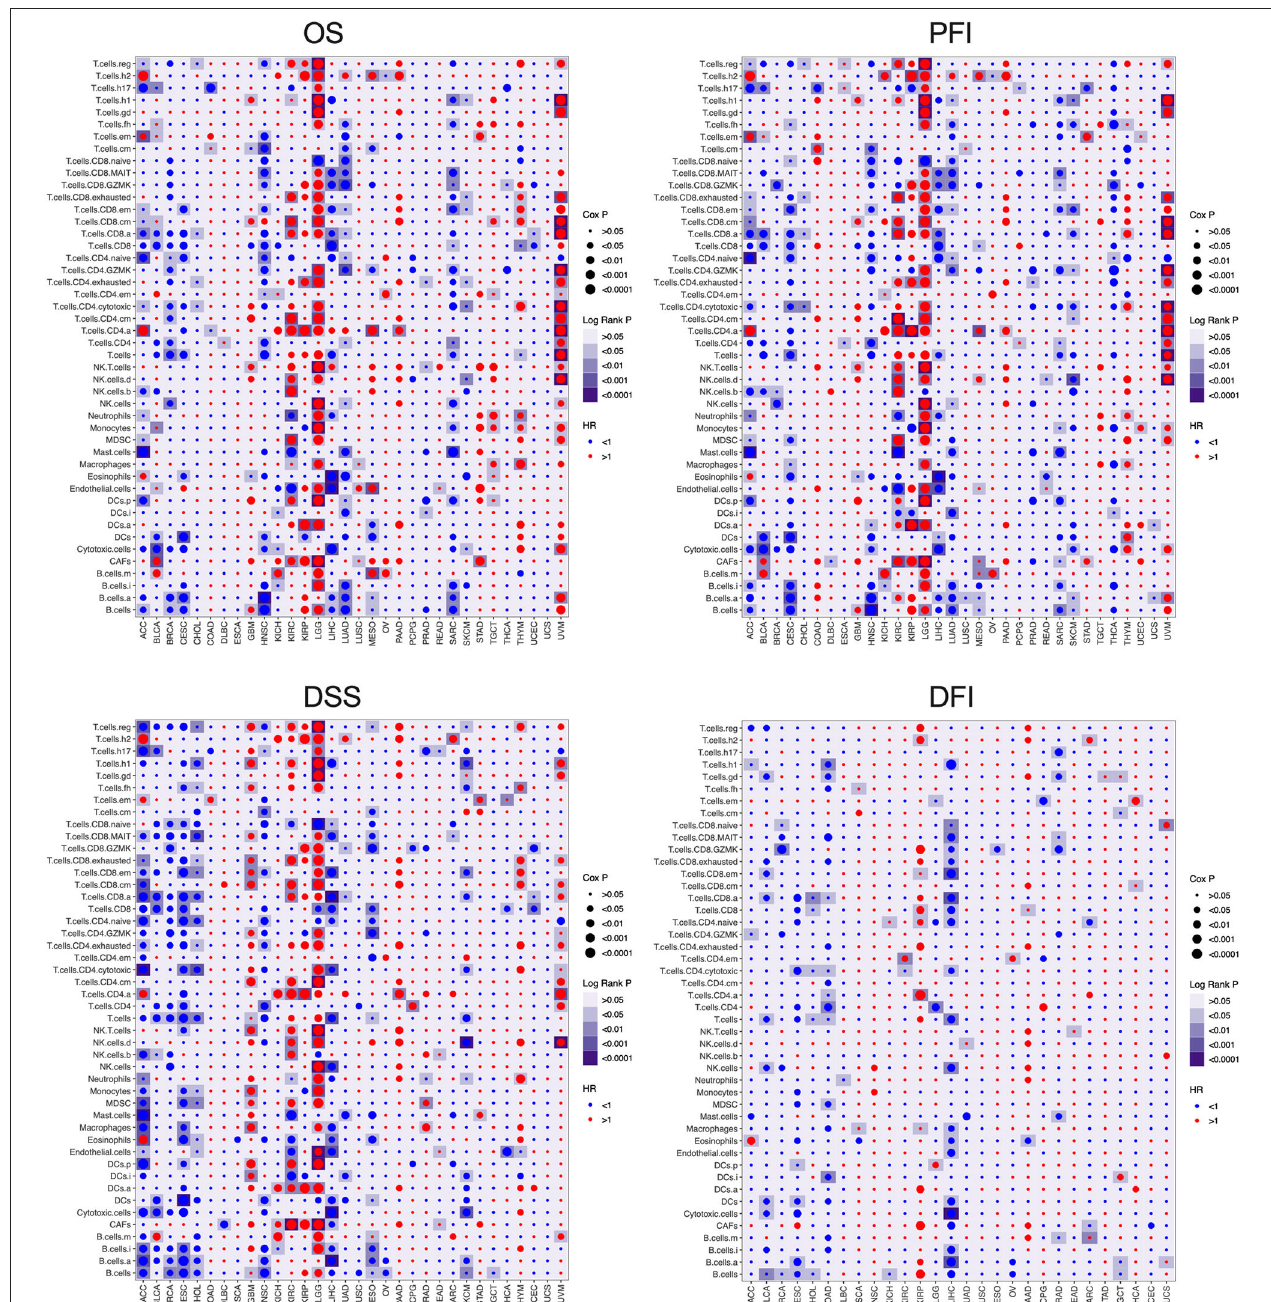
FIGURE 3 | The prognosis value of the infiltrating immune cells in each cancer type. The association between the infiltrating immune cells and the survival of tumor patients was investigated using Cox regression and log-rank methods. The hazard ratio (HR) is < 1.0, indicating a good effect on prognosis, and the HR value is greater than 1.0, indicating an adverse effect on prognosis. Cox P is represented by the size of points, and log-rank P is represented by the gradient of colors. P < 0.05 was used as the cutoff for significance. OS, overall survival; DSS, disease-specific survival; PFI, progression-free interval; DFI, disease-free